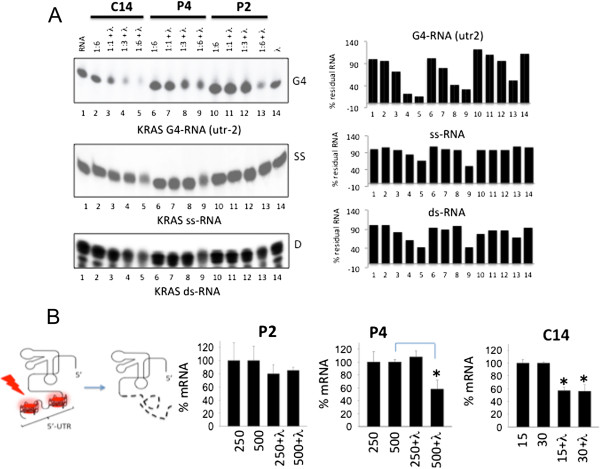
Photoactivated porphyrins degrade mRNA. (A) Photocleavage of RNA fragments from KRAS mRNA in three different conformations: quaduplex utr-2; single stranded (ss-RNA) and double stranded (ds-RNA) after treatment with porphyrin P2, P4 or C14 at ratios 1:1, 1:3 and 1:6 and light (7.2 J/cm2). The histograms show the percentage of clevage. Untreated RNA (lane 1), RNA treated with porphyrin only (lane 2), RNA treated with light only (lane 14), RNA treated with both porphyrin and light (lanes 3–13); (B) Quantitative RT-PCR showing the level of KRAS mRNA in B78-H1 cells after treated with porphyrin P2, P4 (250 and 500 nM) and C14 (15 and 30 nM) and light (7.2J/cm2). RT-PCR analysis performed 1 h after irradiation. The experiment has been carried out in triplicate.